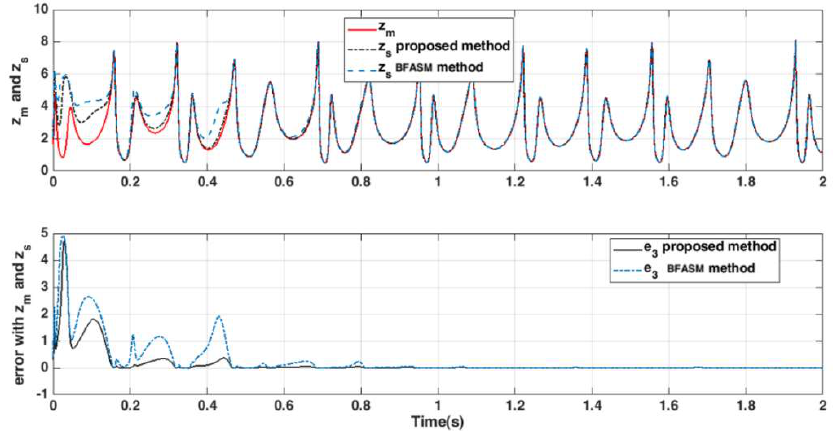
Figure 10. Chaos synchronization and synchronization error of master–slave systems in 𝑧 (cid:3040) , 𝑧 (cid:3046) .